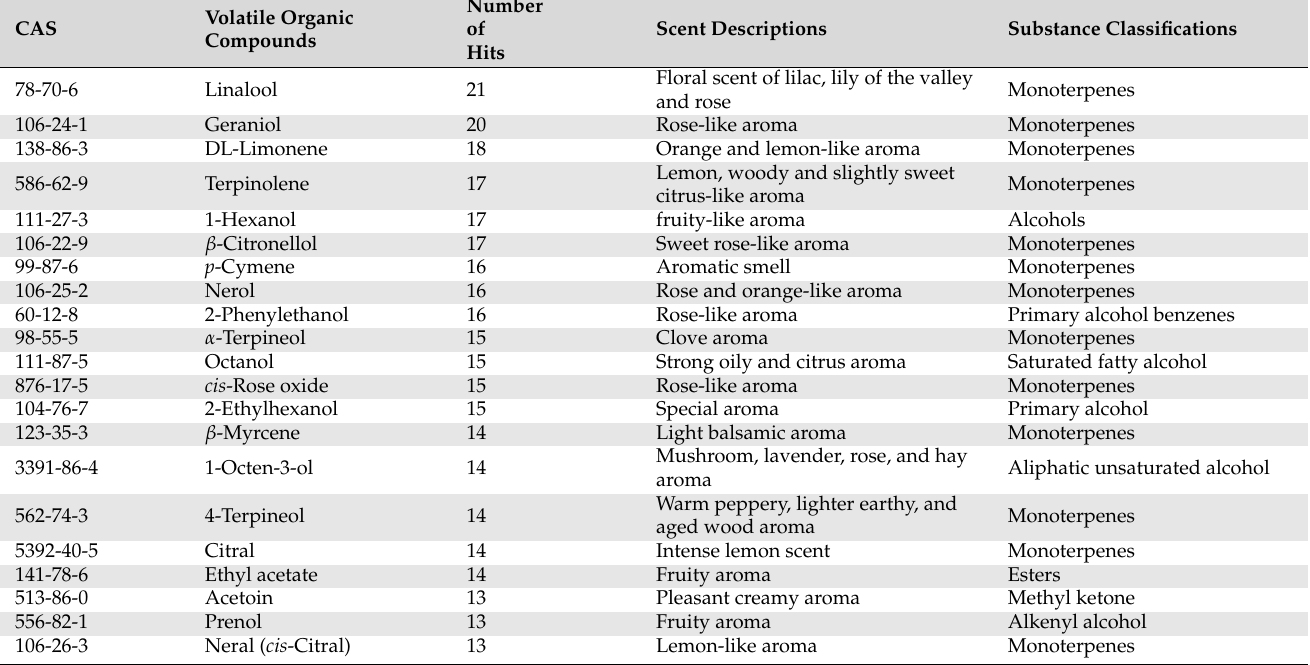
Table 2. List of 21 VOCs commonly found in litchi fruit and their aroma